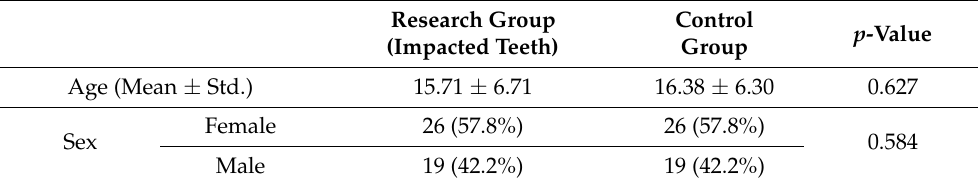
Table 1. Demographic data of the research group and the control group.